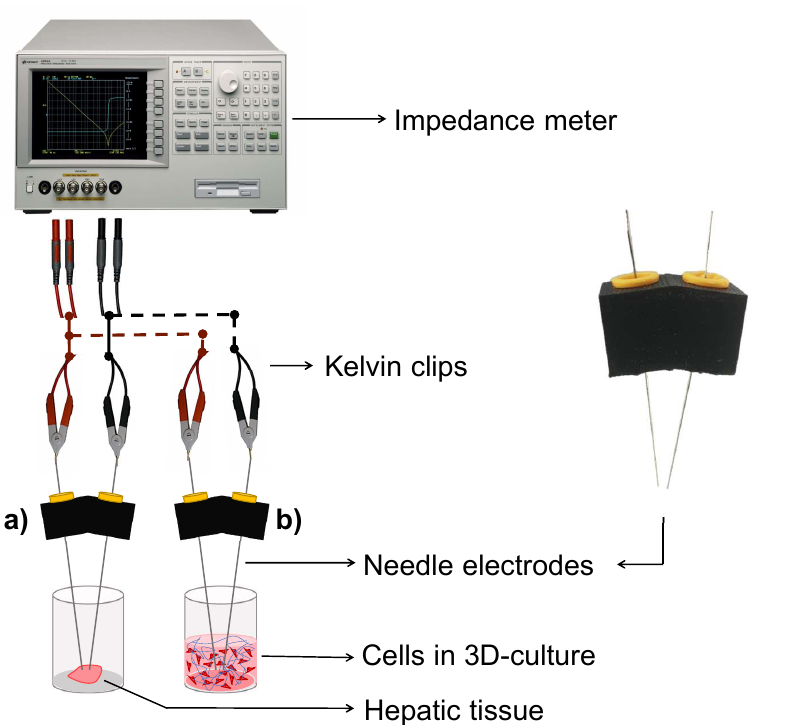
Figure A2. Illustration of the needle electrode setup used for impedance measurements on ( a ) biopsies directly in the absence of culture medium, and ( b ) the 3D cell culture model with Hep-3B cells and type I collagen gel.